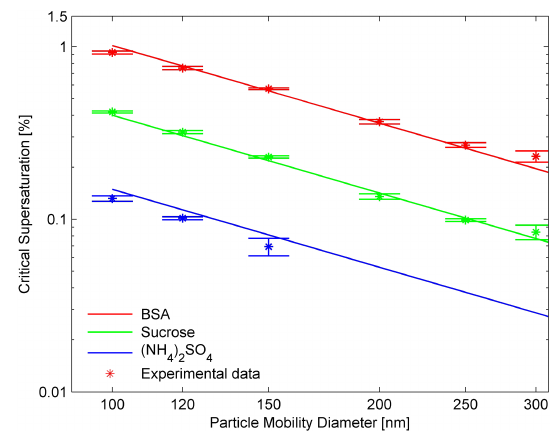
Figure 6. Critical supersaturations against activation mobility diam- eter of pure silica particles with different FHH adsorption isotherm parameters from different studies compared to experimental results. Error bars represent the minimum vs. maximum values of supersat- uration to estimate the s c corresponding to each d b .